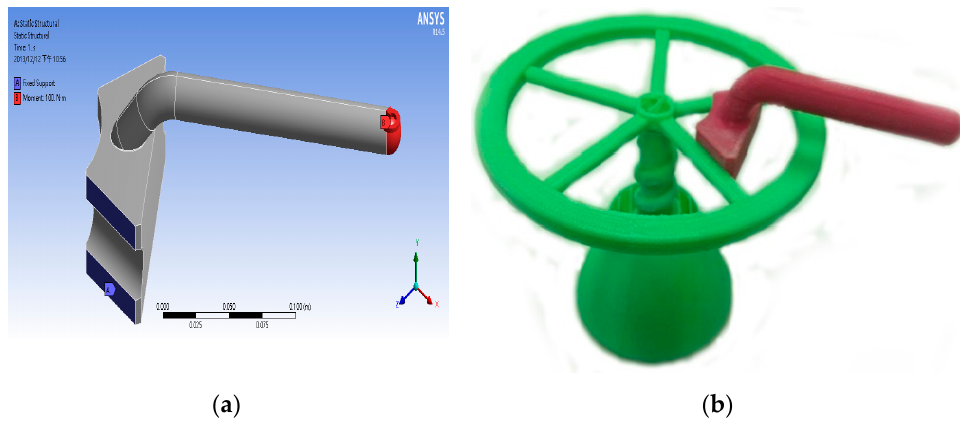
Figure 7. Stress analysis of optimal design combination.